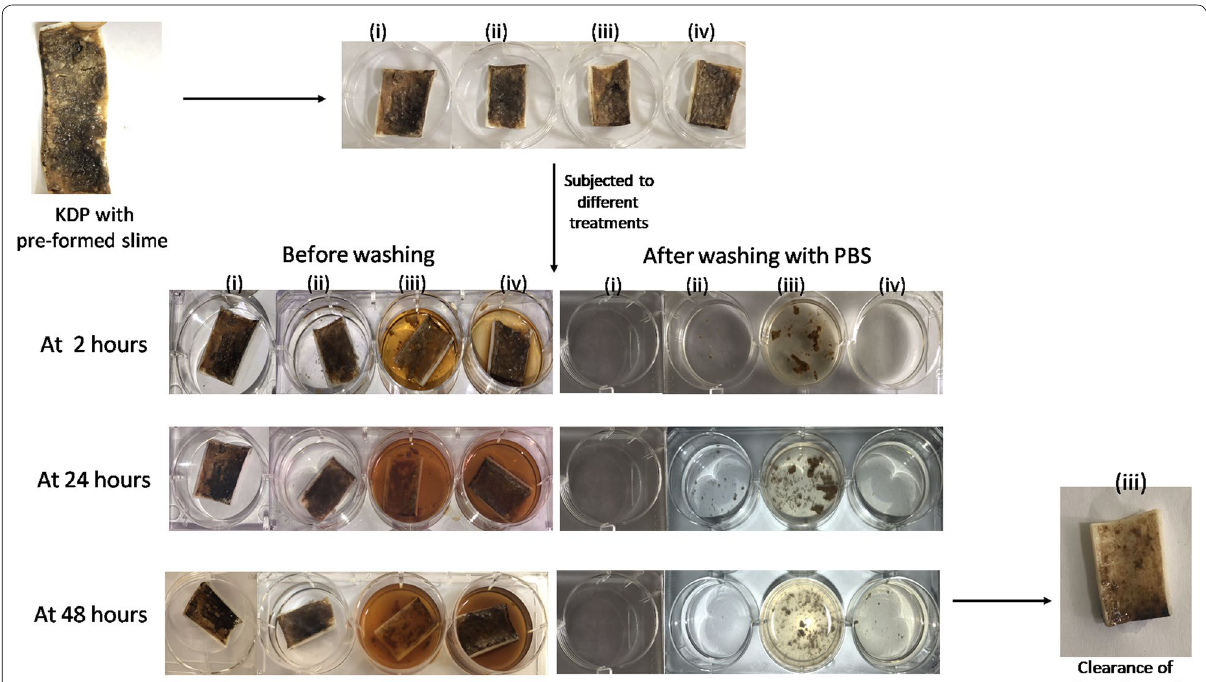
Fig. 4 Clearance of pre-formed slime (Black gunk) deposited on kitchen drainage pipe (KDP) by the action of in-house produced enzyme cocktail after 2 h, 24 h and 48 h. The placement of 4 pieces cut from KDP is shown in the figure as (i) Control (Untreated) (ii) Treated with PBS (iii) Treated with enzyme cocktail (iv) Treated with heat-inactivated